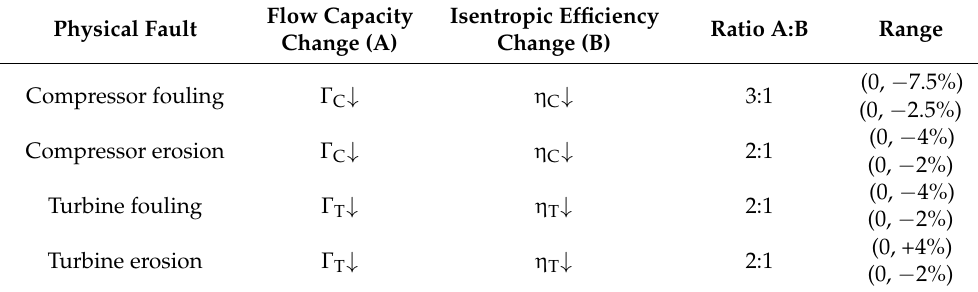
Table 9. Relationship between the physical fault and health